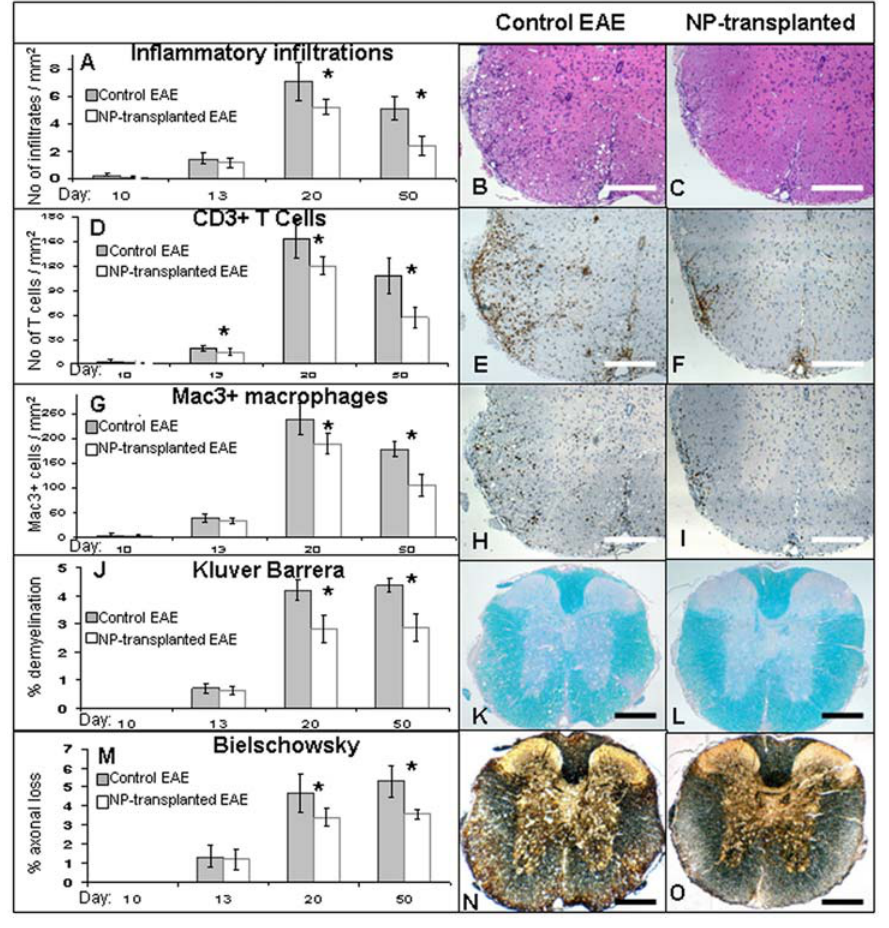
Figure 5. Attenuation of the progression of inflammation and tissue damage in the CNS of NPs-transplanted mice. Pathological examination of spinal cord sections from NP-transplanted and control mice were performed at 10, 13, 20 and 50 days post EAE induction to evaluate CNS inflammation, demyelination and axonal damage. In NP-transplanted mice an attenuation of the number of immune-cell infiltrates (A), T cells (D) and macrophages/activated microglia (G) per mm 2 was evident from day 13 post EAE induction and became significant at days 20 and 50. Demyelination and axonal damage, which were analyzed by loss of Kluver Barrera (J), and Bielschowsky staining (M), respectively, were both significantly reduced at day 20 and 50 post EAE induction. The differences between the study and control groups in the severity of all parameters gradually increased with time. Representative day 20 images of H&E staining (B, C), immunostaining for CD3 (E, F) and Mac3 (H, I), Kluver Barrera staining (K, L) and Bielschowsky silver staining (N, O). * P , 0.05. Scale bars: 100 m